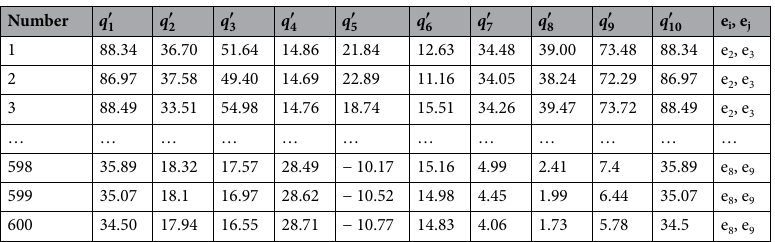
Table 3. The sample set of multifaults for the T-shaped angle-joint ventilation network.